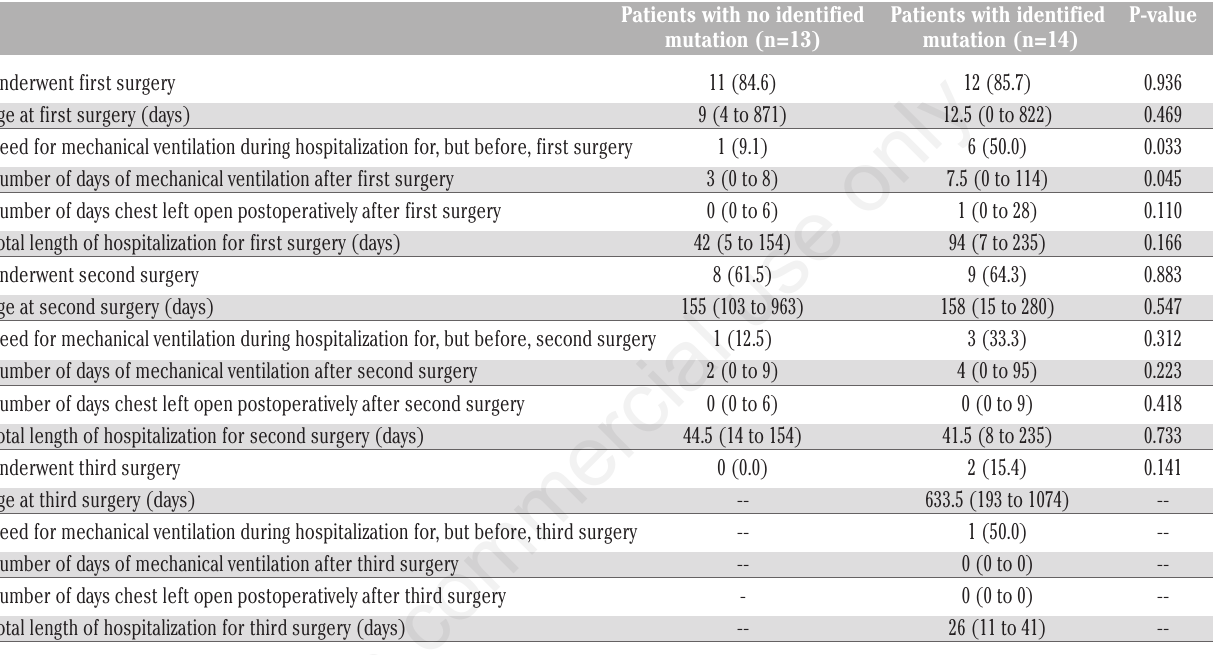
Table 2. Surgical data of cohort based on isomerism